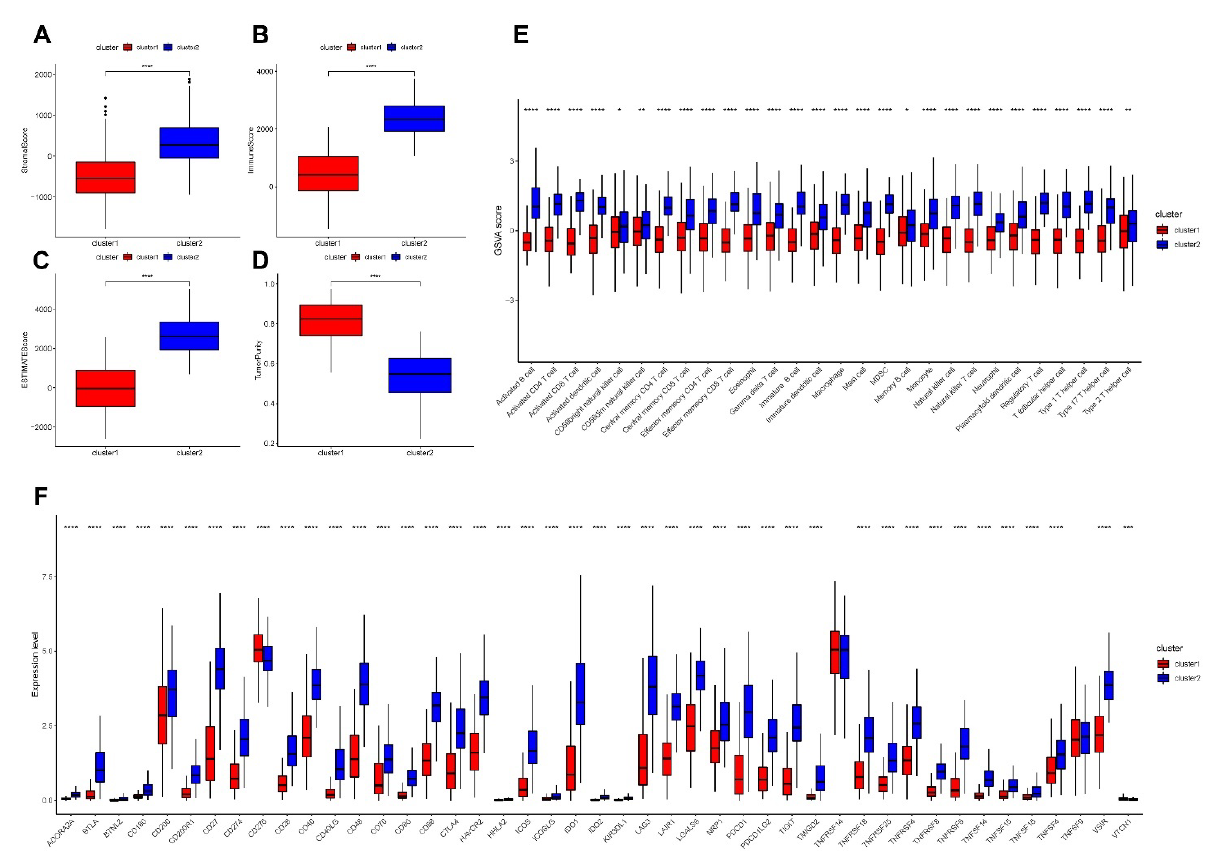
Figure 6. ( A – E ) Differences in immune infiltrating cells between subtypes. ( A ) Immunization score difference display of StromalScore. ( B ) Immunization score difference display of ImmuneScore. ( C ) Immunization score difference display of ESTIMATEScore. ( D ) Immunization score difference display of TumorPurity. ( E ) Differences in immuno-infiltrating cell enrichment scores (* p < 0.05, ** p < 0.01, **** p < 0.0001). ( F ) Differences in immune checkpoint expression between subtypes. Our results showed significant expression differences in 43 of the 45 immune checkpoints (*** p < 0.001, **** p <